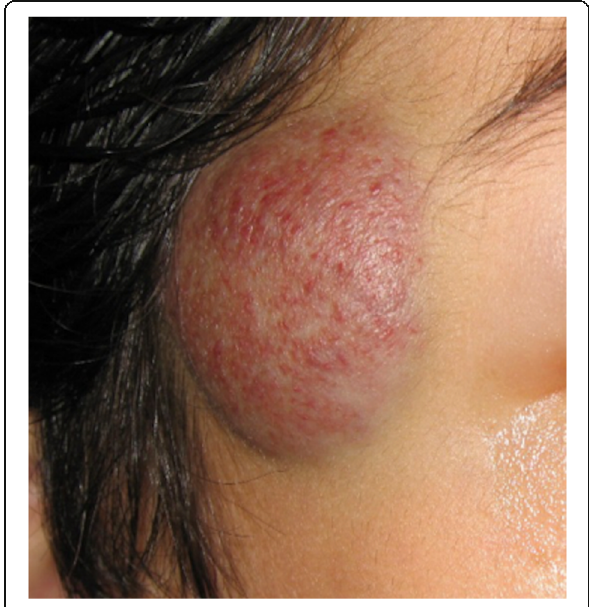
Fig. 2 Classic appearance of a non-involuting congenital haemangioma (NICH). They have a more purple colour than the commoner infantile